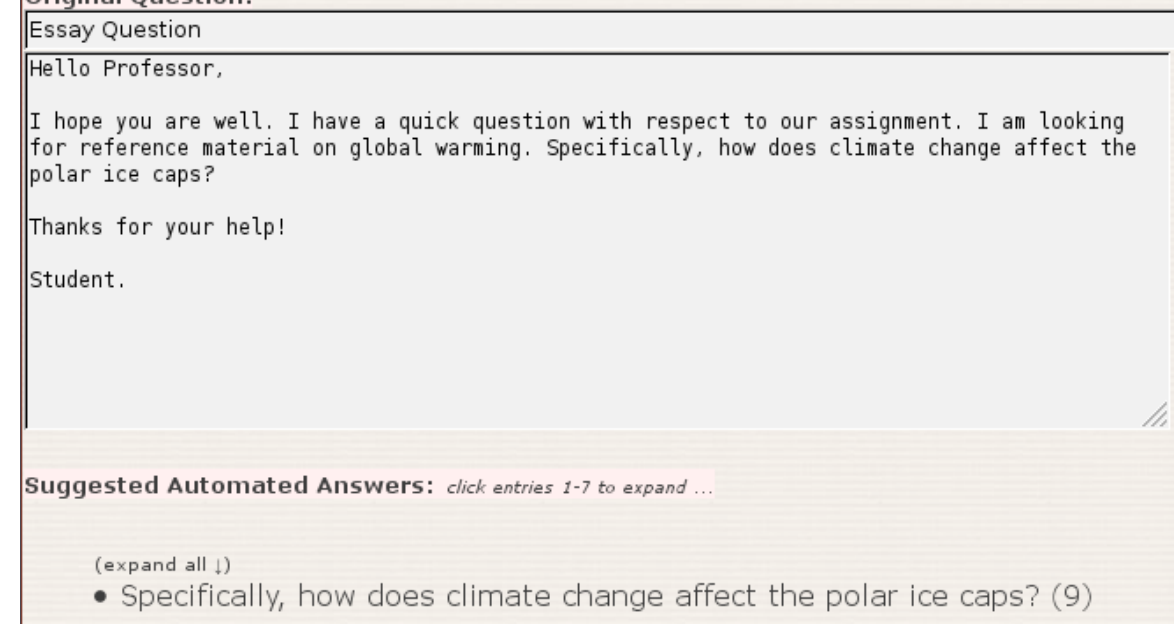
Figure 5 . Automated response returned by the QA system.